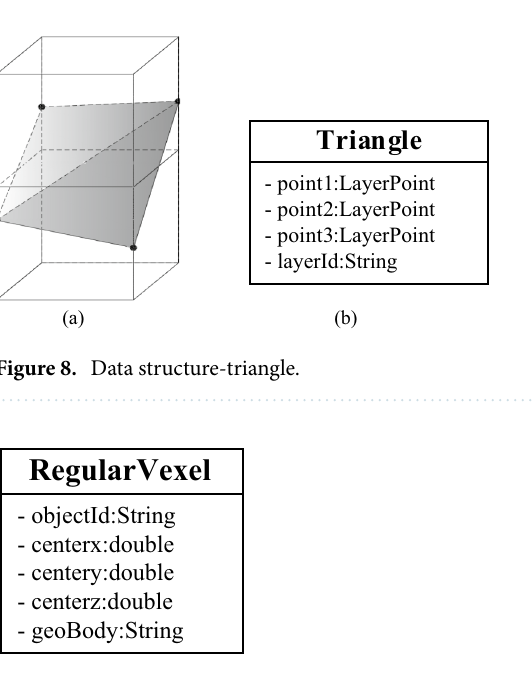
Figure 9. Data structure-regular voxel.